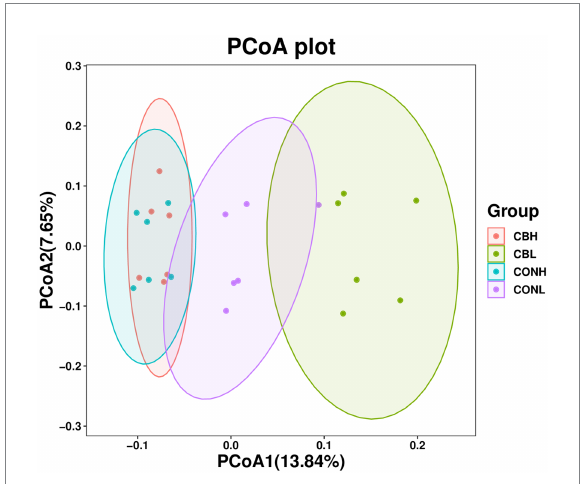
FIGURE 1 Principal coordinates analysis (PCoA) based on unweighted uniFrac distance matrices of microbiota in ruminal fermentation fluid supplemented with CB at low or high media pH after 24 h of in vitro incubation. CONH, control at media pH 6.6; CONL, control at media pH 6.0; CBH, CB supplemented at 1 × 10 6 CFU/ bottle at media pH 6.6; and CBL, CB supplemented at 1 × 10 6 CFU/bottle at media pH 6.0.